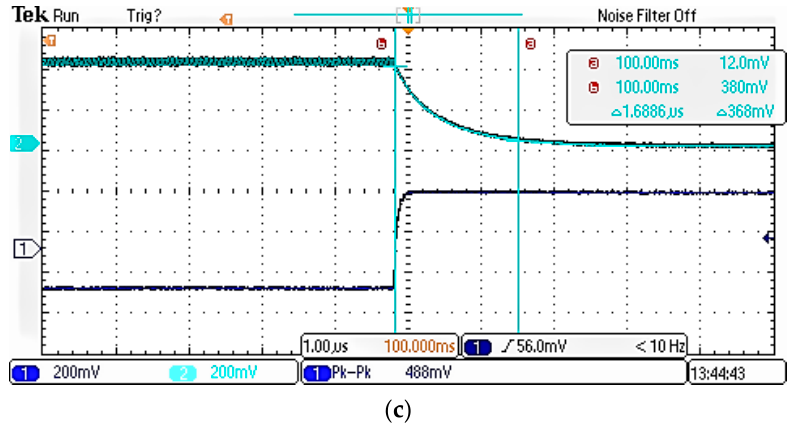
Figure 3. Switching speed with different coupling capacitance values ( a ) 100 pf ( b ) 500 pf and. ( c ) 1000 pf.